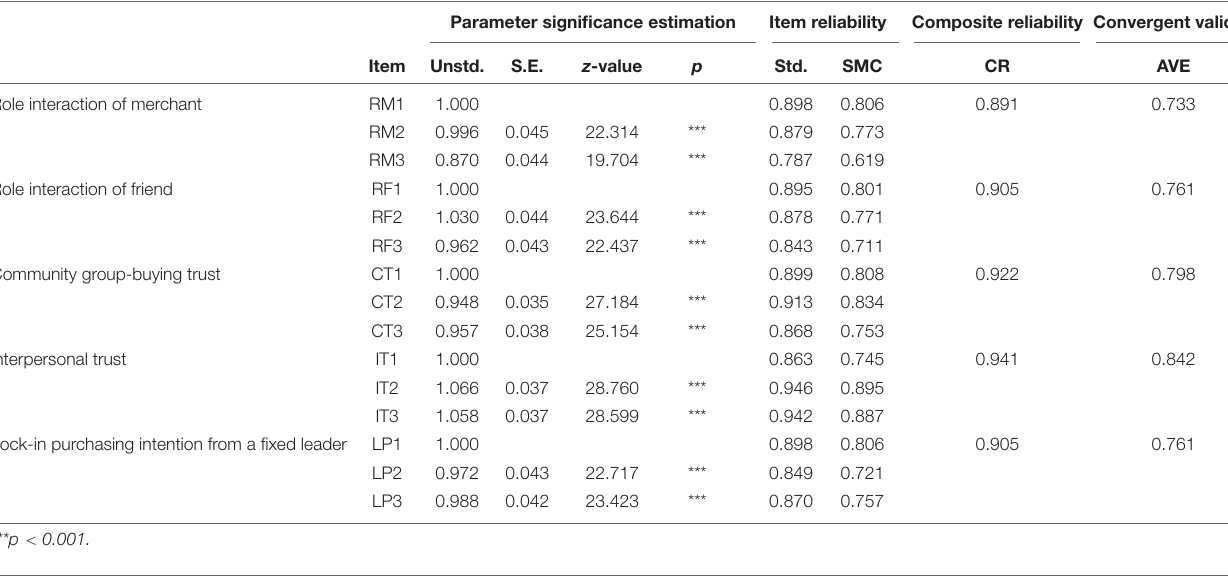
TABLE 2 | Reliability analysis of research scale.